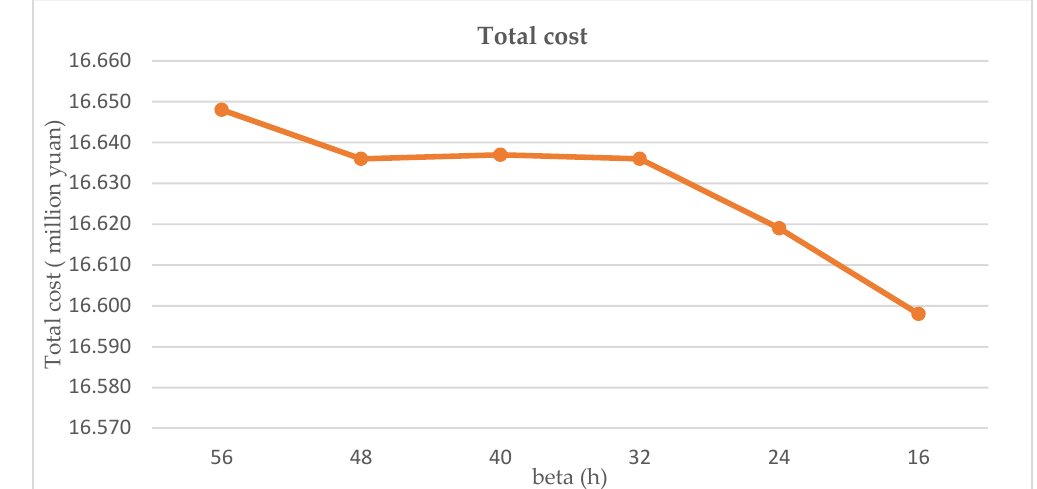
Figure 11. Sensitivity analysis of total risk regarding the changes in time limit.